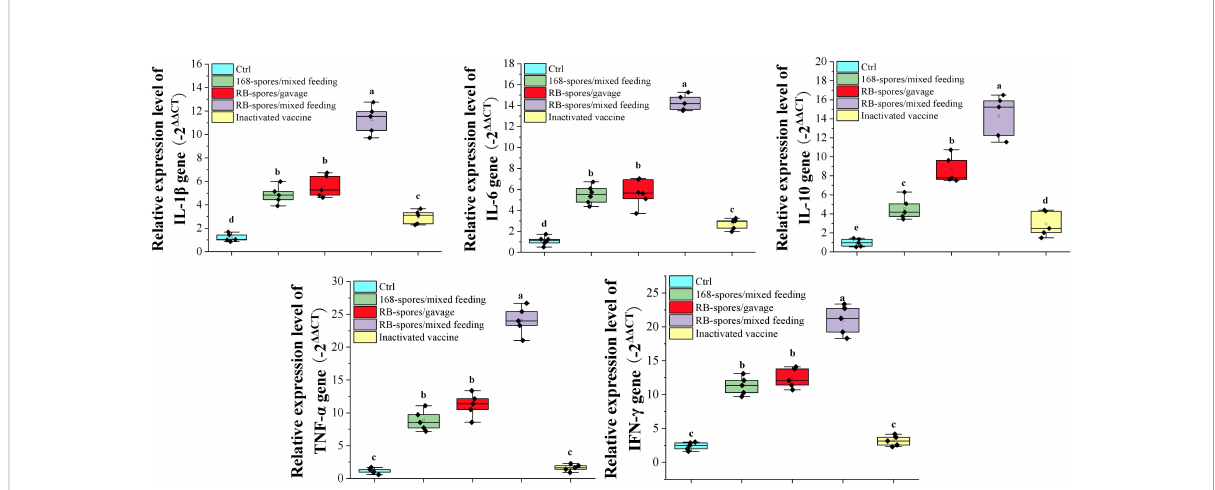
FIGURE 6 Expression of small intestine cytokines detected by quantitative real-time PCR. The expressio n levels of cytokines IL-1 b , IL-6, IL-10, TNF- a and IFN- g were expressed by the value of -2 DD CT . Data are presented as mean ± standard deviation (n=5). One-way ANOVA followed by a Friedman test was performed, bars with different letters indicate signi fi cant difference ( P <